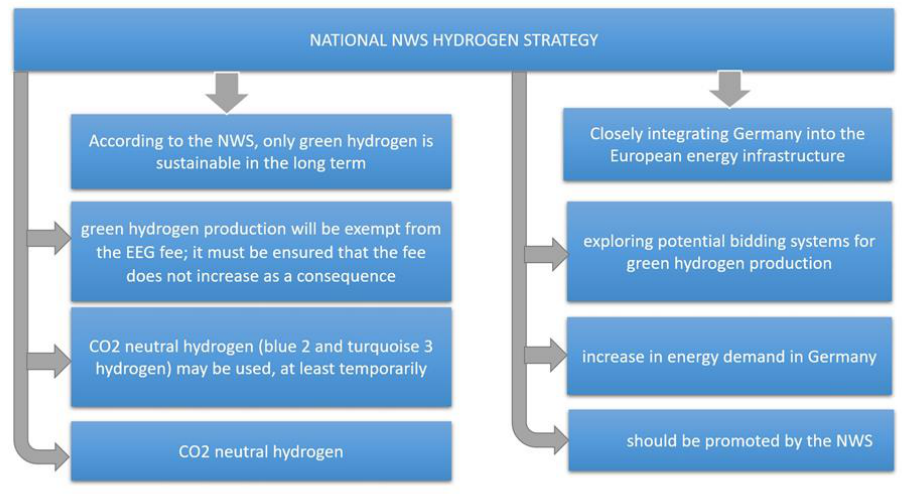
Figure 13. National hydrogen strategy in Germany [80].